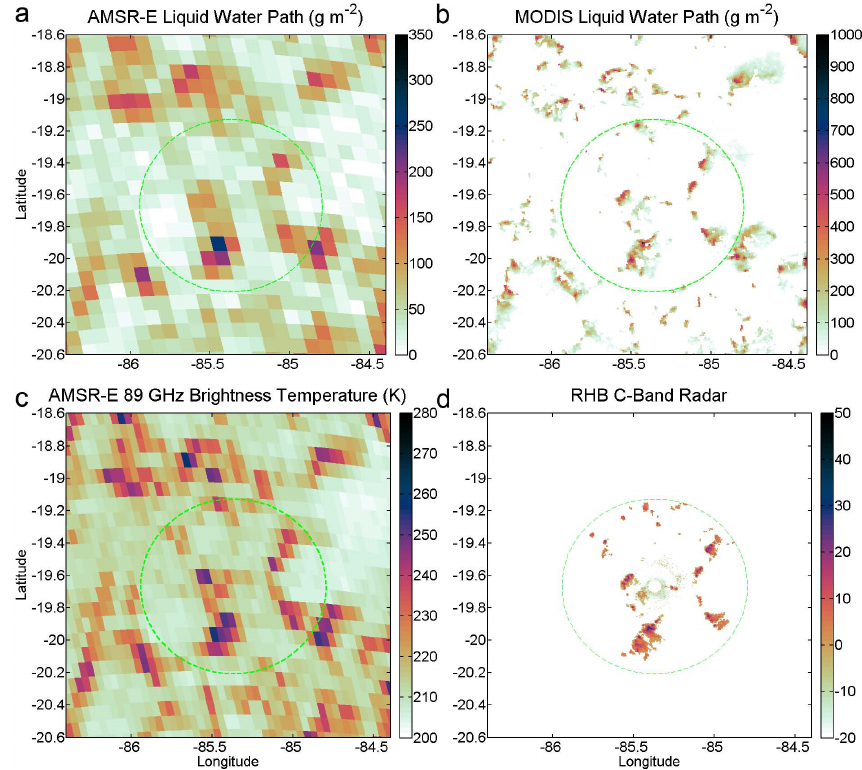
Fig. 1. Detailed comparison among (a) AMSR-E LWP, (b) MODIS Level 2 Cloud Water Path, (c) AMSR-E Level 2 89-GHz brightness temperature, and (d) C-band ship-borne radar reflectivity data (dBZ) obtained at 19:36UTC on 27 October 2008 in the southeast Pacific during VOCALS experiment. The 60km radius range ring from the radar is overlaid on each image. In order to highlight gradients in LWP, the dynamic range of the color scales differs between (a) and (b)